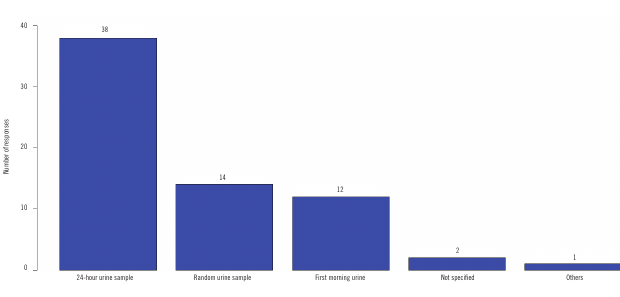
figurE 6 − Recommended samples to measure albumin in the